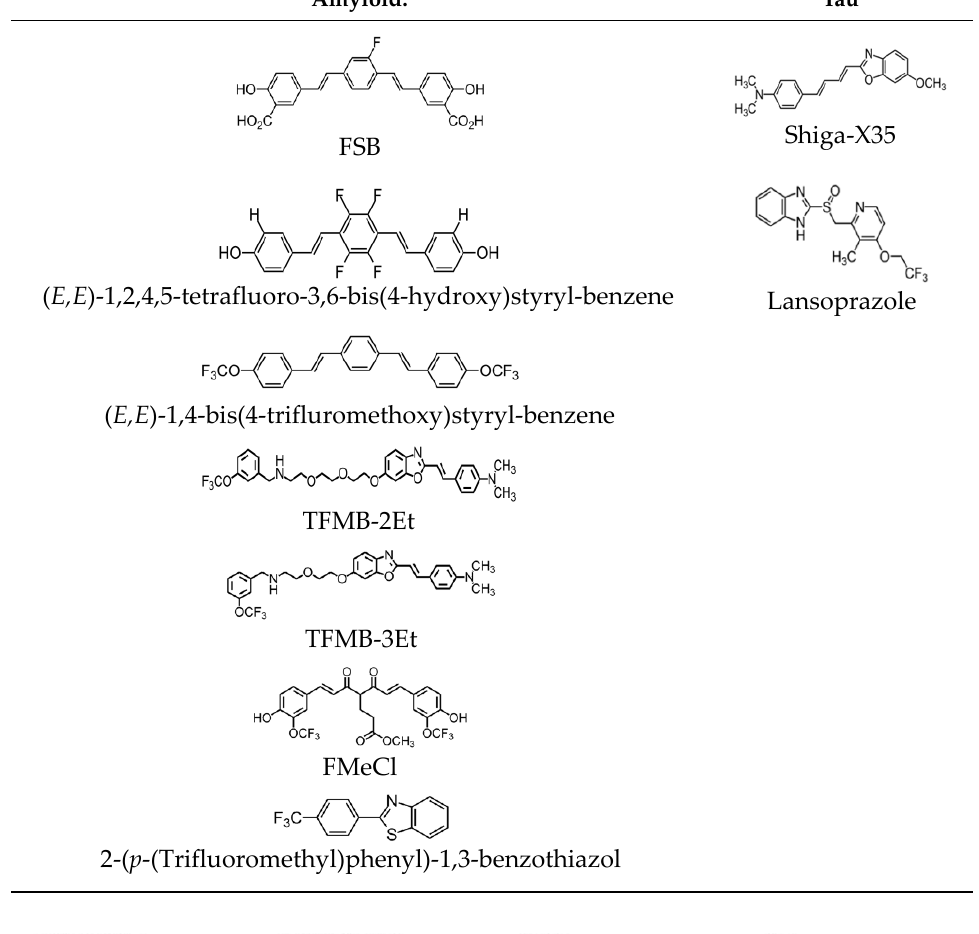
Table 1. Molecular probes for the detection of amyloid- β (A β ) or neurofibrillary tangles (NFTs) using 19F MRI.